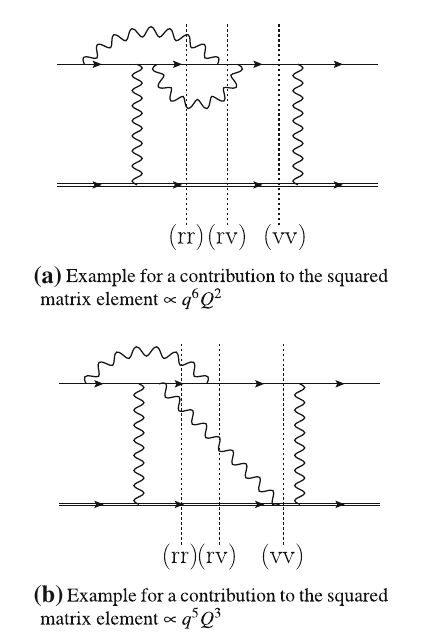
Fig. 5 Examples of NNLO QED contributions to M ( 0 ) ( 2 ) (rv), and M n (vv). Analogous contributions with q { 4 , 3 , 2 } are understood